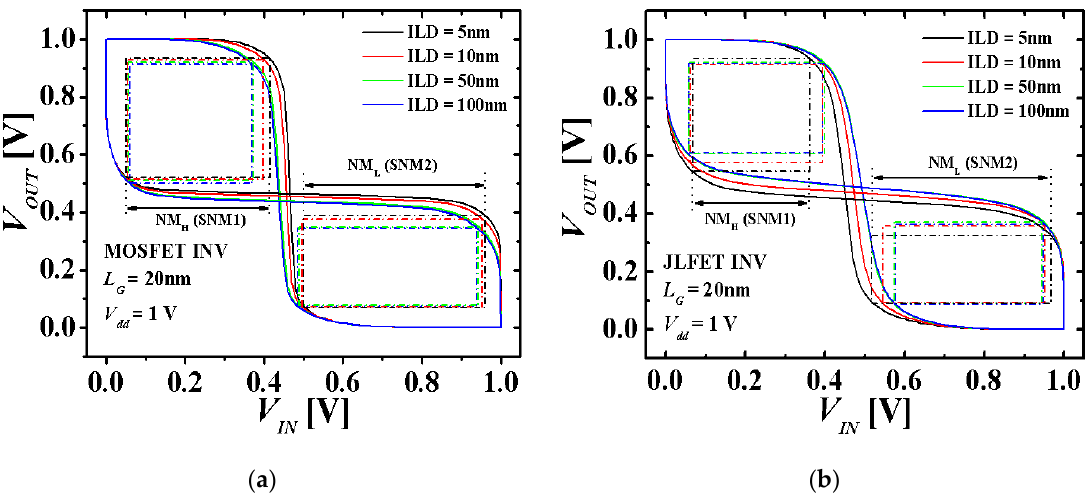
Figure 8. Static noise margin (SNM) characteristics of ( a ) M3INV-MOS cell and ( b ) M3INV-JL cell. Here L G = 20 nm and V dd = 1 V. Black, red, green, and blue lines denote the coupled voltage transfer characteristics (VTCs) of M3INV-MOS and M3INV-JL with T ILD = 5, 10, 50, and 100 nm, respectively.